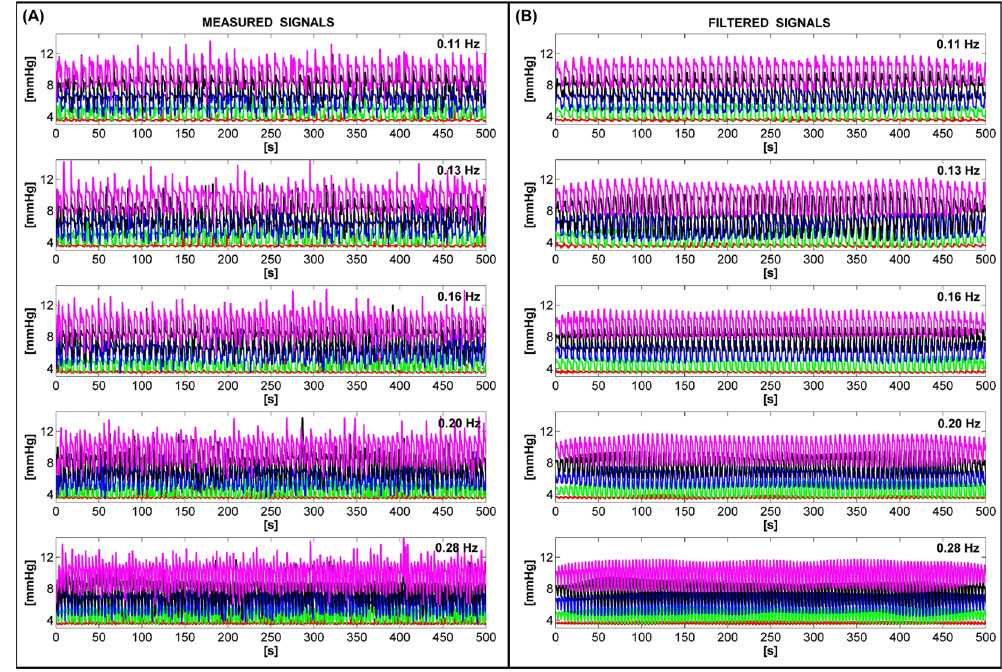
Figure 2. The measured ( A ) and filtered ( B ) air pressure signals for tests performed in pulsating operation